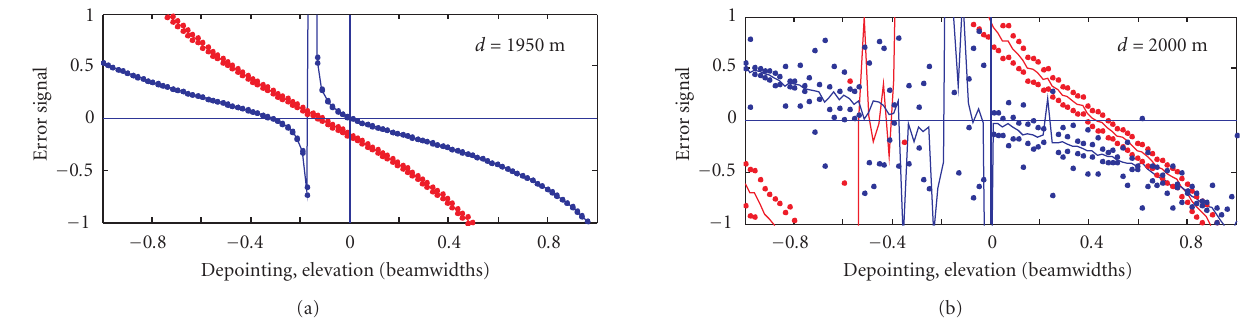
Figure 10: Error function, as a function of elevation error, for the standard and crossfeed monopulse over a rough sea, in presence of 1 ◦ phase error in one of the primary channel. (a) Blue: crossfeed; solid line: average; bullets: standard deviation limits around the average values. (b) Red: standard feed; solid line: average; bullets: standard deviation limits around the average values.